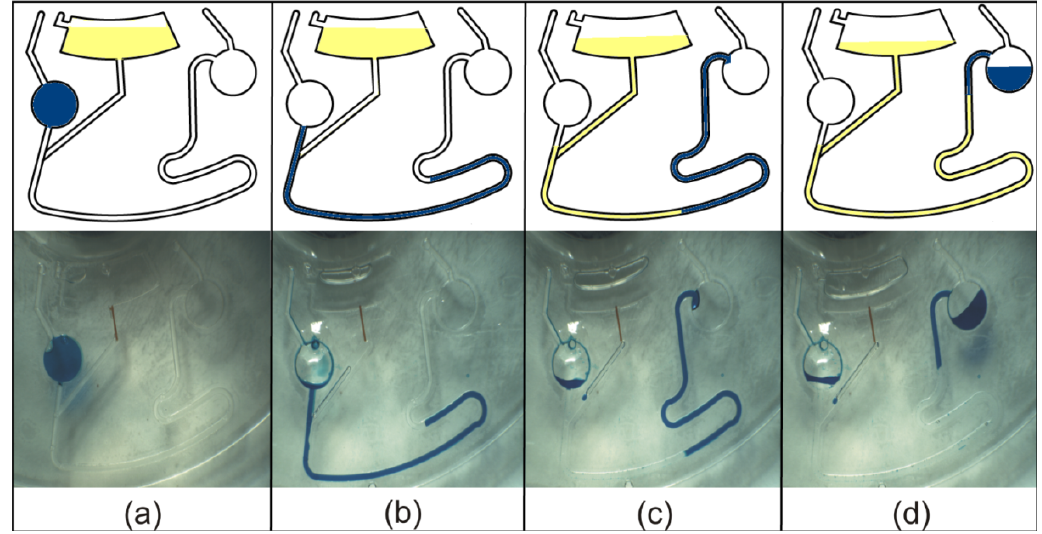
Figure 2. Schematics and strobed images of the liquid-liquid pump in operation; t indicates the time elapsed. (a) Sample Chamber is filled with PAS (blue); 0 rpm, t = 0 s; (b) PAS is spun into the Transfer Channel; 240 rpm, t = 30 s; (c) Pumping liquid (yellow) has begun displacing PAS, which has moved towards the Final Chamber; 400 rpm, t = 90 s; (d) PAS has been displaced into Final Chamber by the pumping liquid; 400 rpm, t = 150